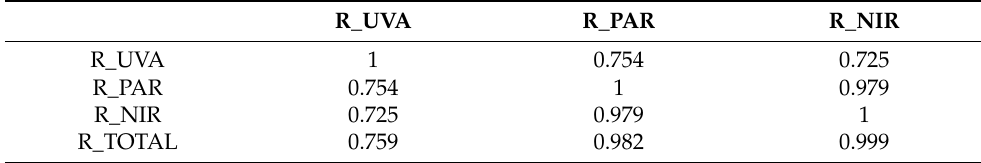
Table 3. Correlations between reflected radiation in different regions.